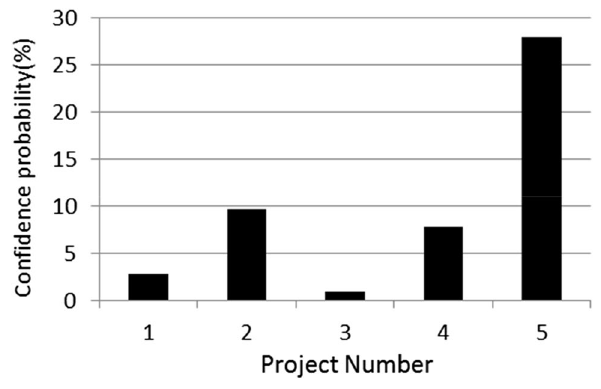
Fig. 10 Corporate confidence probability plotted against the project number for the case where the OWI is taken from the Kelly formal- ism for the five projects given in Table 4 and when the potential gain for each case is built into the estimate of corporate